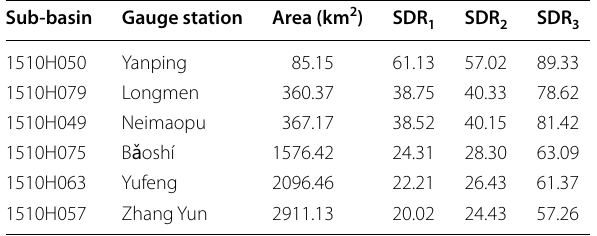
Each sub-basin represents the whole upper areas where water flows into its gauge station; SDR 1,2,3 values were obtained from the three SDR equations, respectively